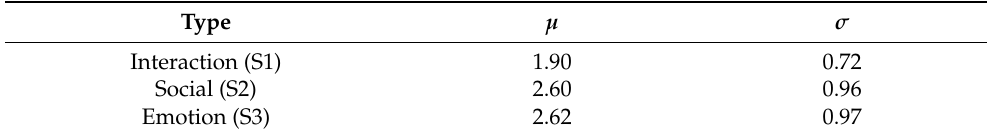
Table 5. Average ( µ ) and standard deviation ( σ ) values for each NARS type. Values close to one represent positive attitudes and values close to five represent negative attitudes. Because the NARS-S3 is using positive questions, it is the five’s complement of the mean that is shown.